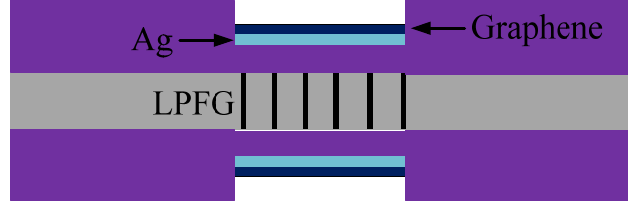
Figure 12. The gas sensor based on SPR-LPFG with Ag and graphene [51].